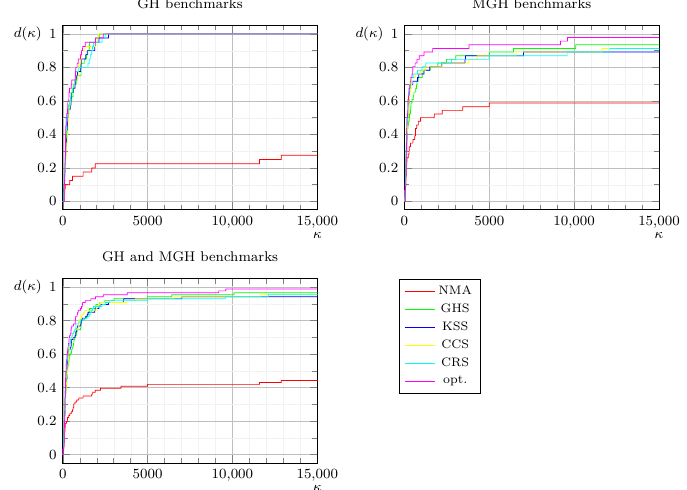
Figure 3. Data profiles for GH and MGH benchmark sets, separated and combined. No tolerance- based algorithm termination was applied ( Tol f = Tol X =